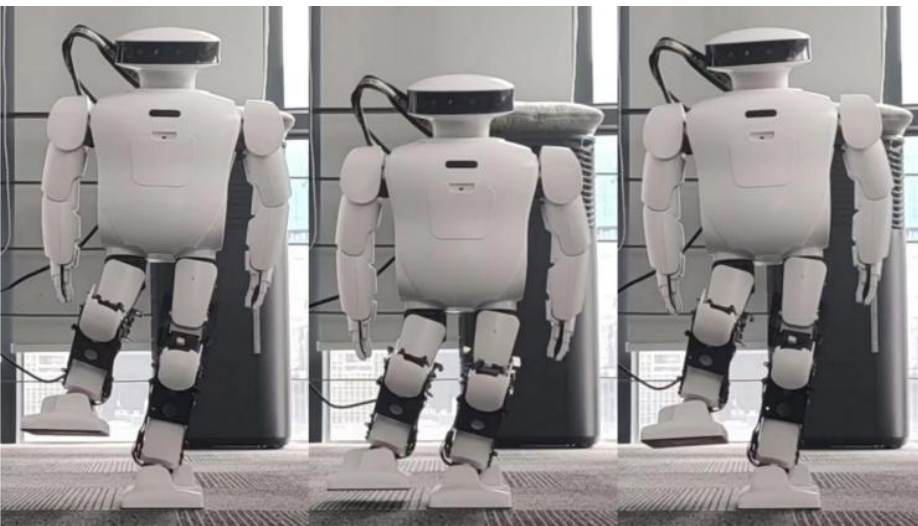
Figure 23. The robot performs a deeper squat with spring compensation.